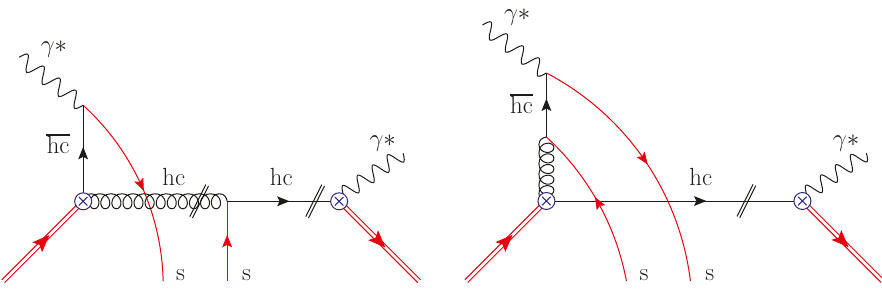
contribution onto SCET. O 7 (cid:13) (cid:0)O 8 g